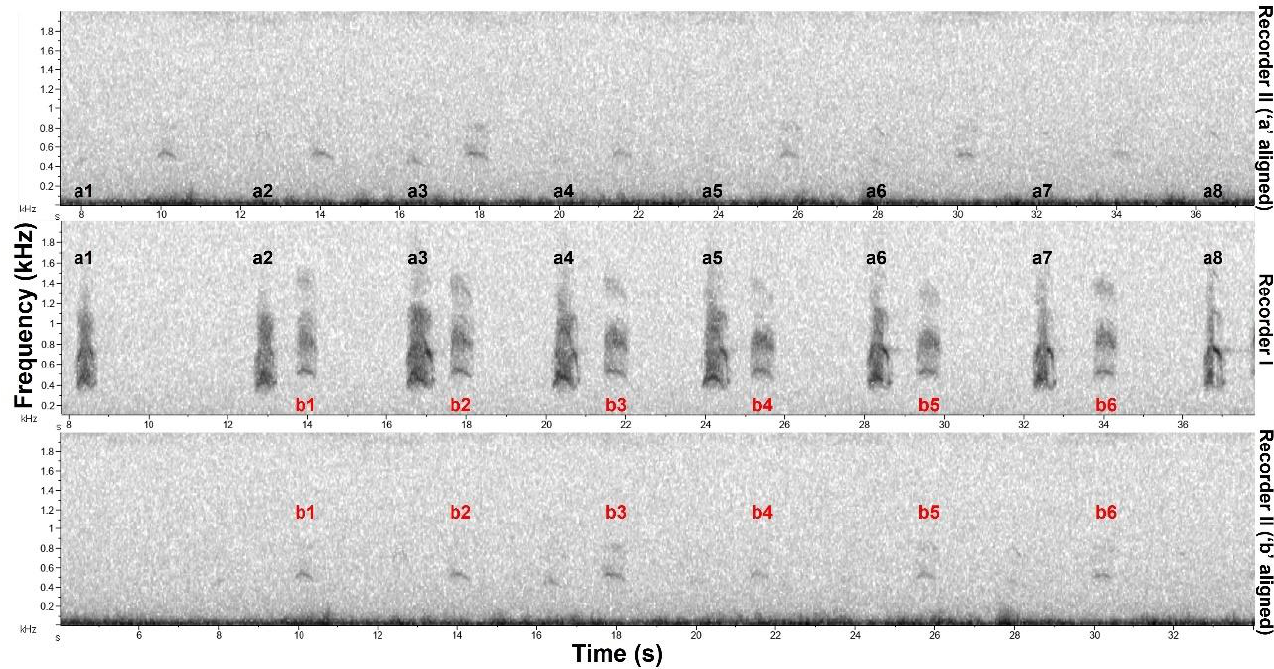
Figure 3. Interactive roar-bark sequence with two participating maned wolves (a and b). This sequence was registered in two recorders (I and II). Roar-barks (numbers) only align in recorder II one animal at a time (top and bottom) because individuals are at different positions. The spectrogram shown in recorder I (middle) is a portion of the first roar-bark sequence example in Figure 2.